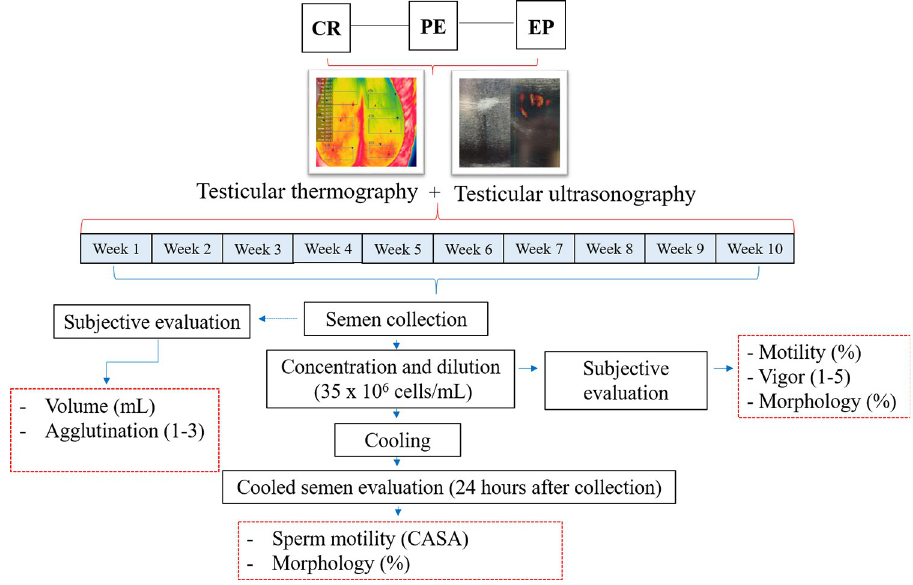
Fig 1. A representative diagram of experimental designs, sampling routine, and evaluated